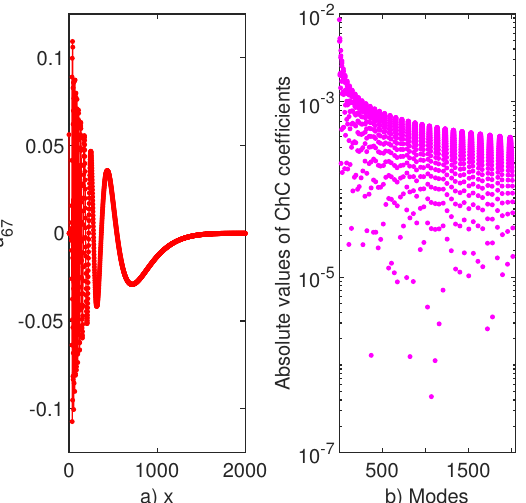
Figure 10. ( a ) The eigenvector corresponding to the first positive eigenvalue of hydrogen atom eigenproblems (1), (5), and (6) computed by mapped ChC with scaling factor c : = 2 and N : = 2024, l : = 1. (left panel). ( b ) In the right panel, in a log-linear plot, we display the Chebyshev coefficients of this eigenvector.